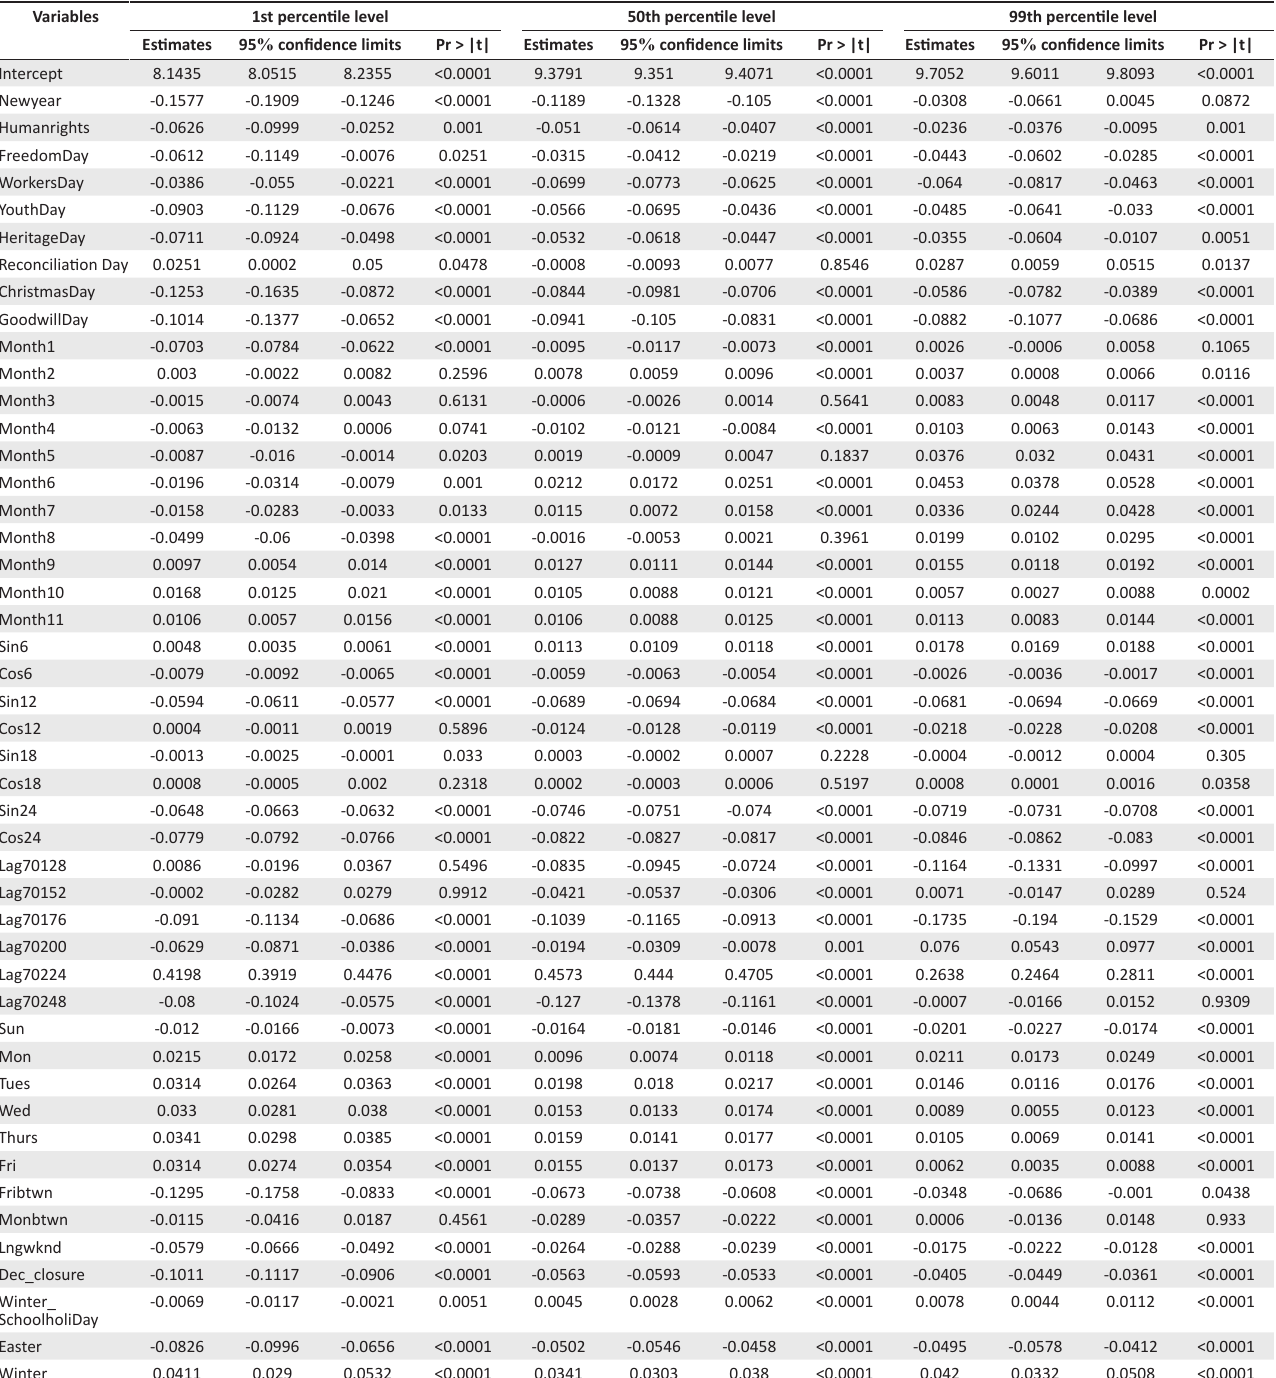
TABLE 1-A1: Selected quantile regression